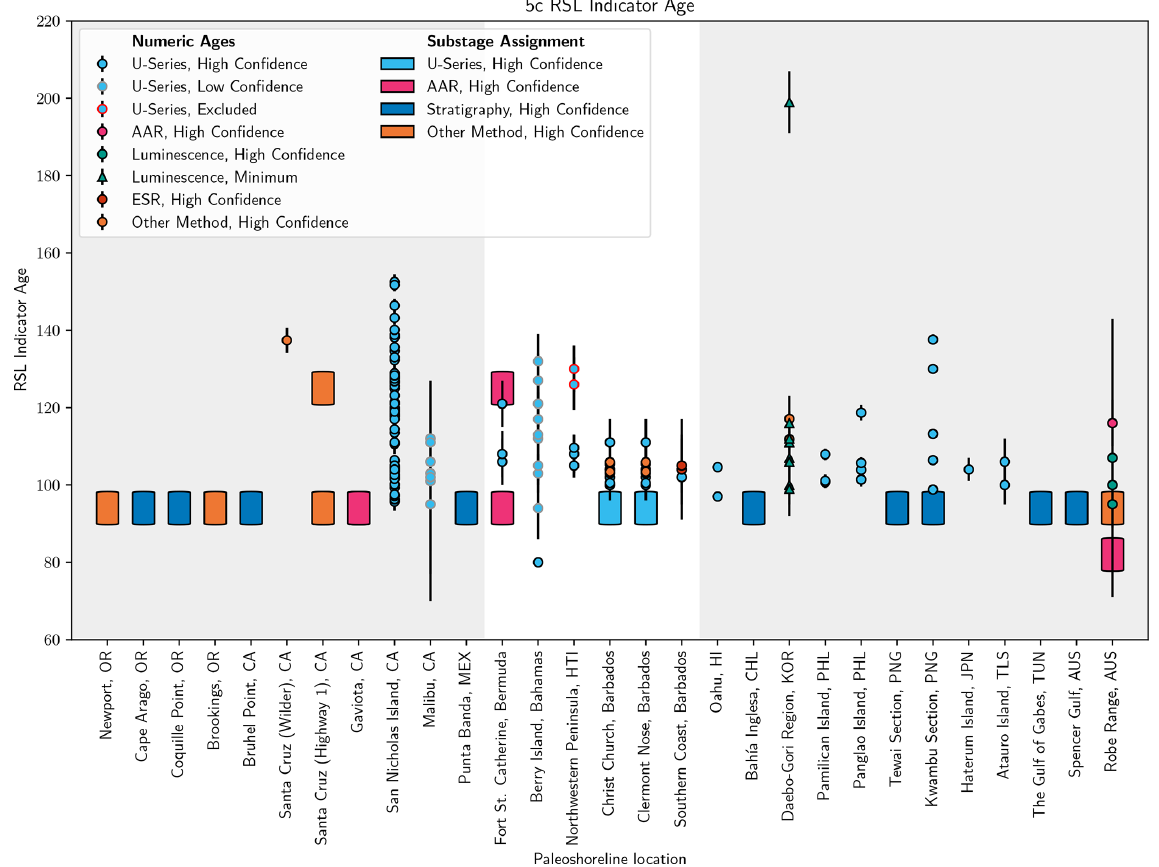
Figure 5. Age assignments for MIS 5c RSL indicators cropping out at the locations listed on the horizontal axis. See Fig. 4 caption for a description of